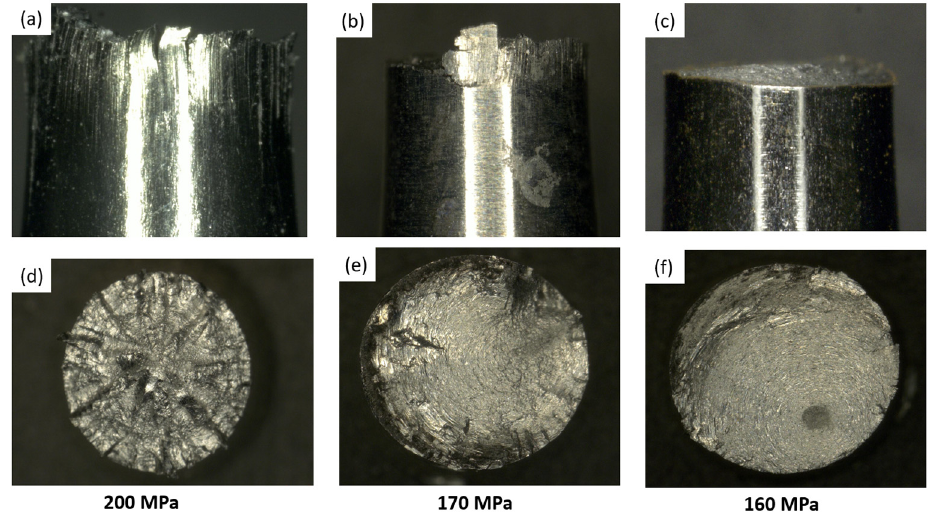
Figure 5. Macro-failure analysis of HT samples: ( a , d ) correspond to the shear stress amplitude of 200 MPa, ( b , e ) correspond to 170 MPa, and ( c , f ) correspond to 160 MPa. Note that the diameter of the fracture surfaces is about 4 mm.